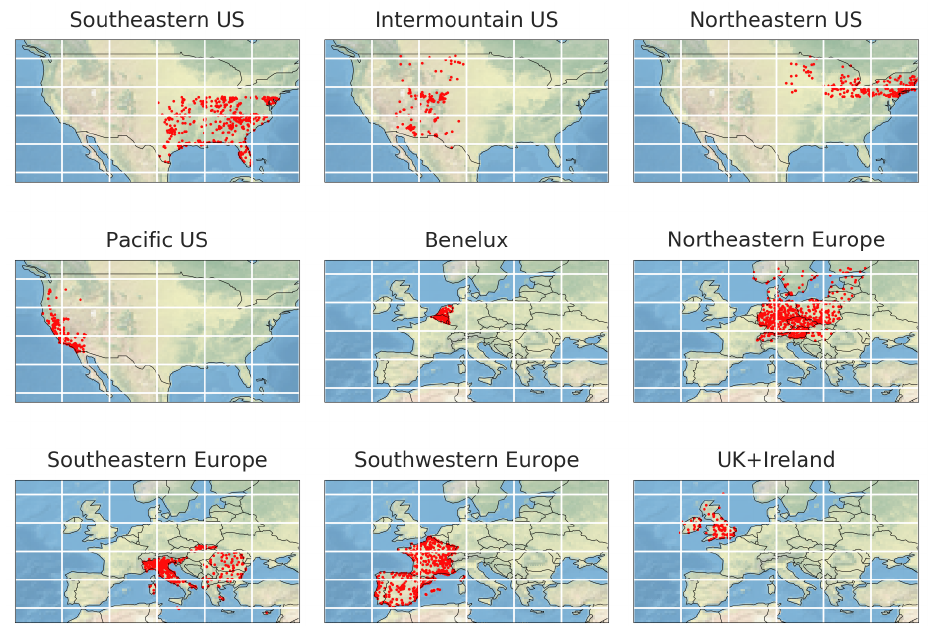
Figure A2. Surface monitoring sites in the US and Europe grouped by subregions as analyzed in the text. Background image © Natural Earth (public domain